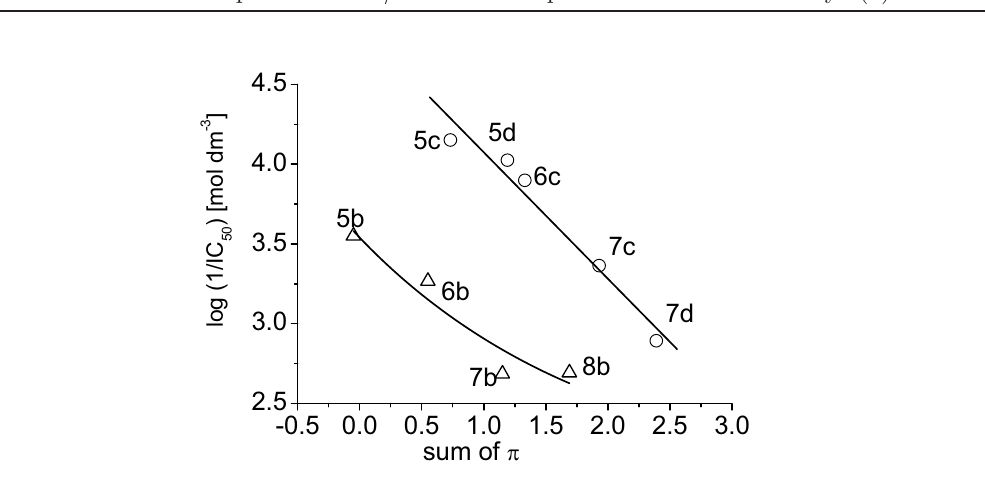
Fig. 1 Dependence of PET-inhibitory activity of the compounds on the sum of π parameters of R 1 , R 2 and R substituents for spinach chloroplasts.